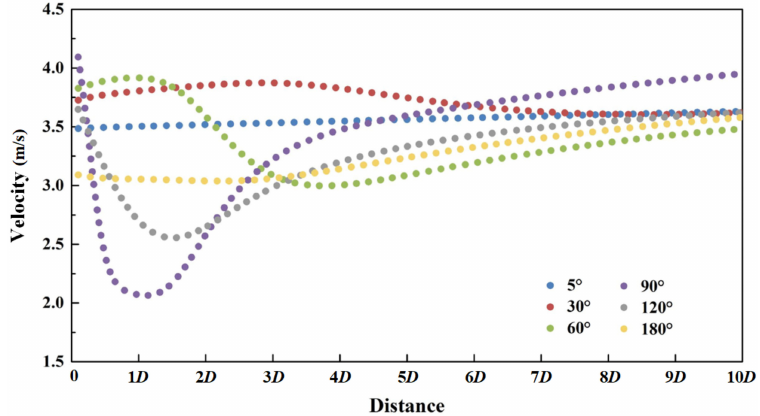
Figure 8. Velocity downstream of bend pipe with different bending angles.